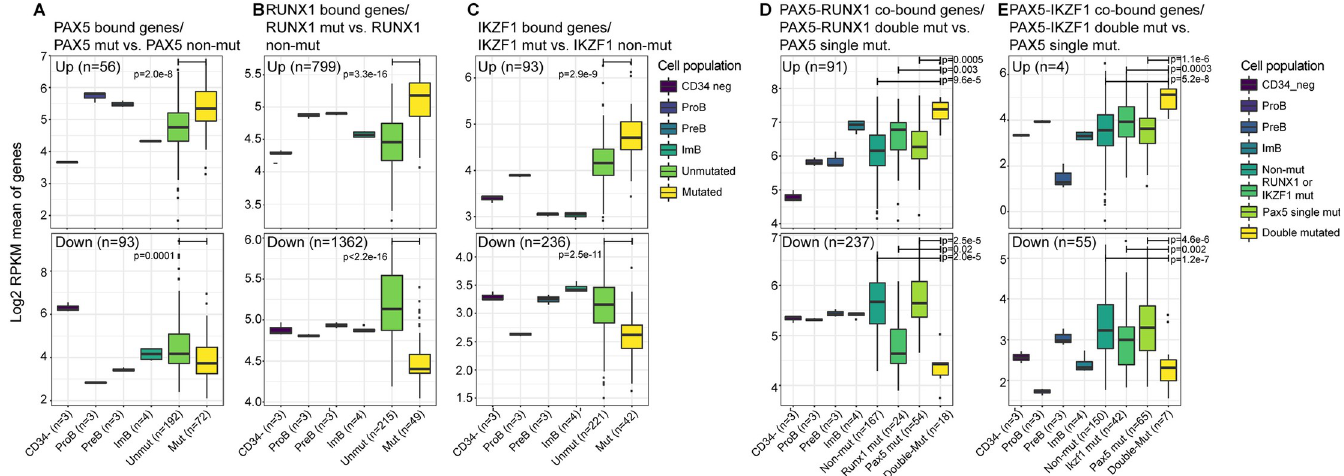
Fig 5. Mutations in B-lineage transcriptional regulators affects expression of their target genes in human leukemia. The figure displays diagrams over a differential expression analysis in a cohort of 264 B-ALL samples and 13 samples from normal HSC (CD34 - ) or B-cell progenitor (Pro-B, Pre-B or Immature B) populations as indicated. PAX5, RUNX1 and/or IKZF1 target genes are defined in the human B-ALL cell line NALM6 using ChIP- and PLAC-sequencing (for details see Methods). Boxplots describe the mean log2 RPKM gene expression for each sample category as defined by differential genes between mutated and unmutated samples (A-C) ; ( A) Expression of PAX5 bound genes in PAX5 mutated vs unmutated leukemia cells, (B) RUNX1 bound genes in RUNX1 mutated vs unmutated or ( C) IKZF1 bound genes in IKZF1 mutated vs unmutated B-ALL. Panel (D, E) displays boxplots of genes co-bound by ( D) PAX5-RUNX1 or ( E ) PAX5-IKZF1 differentially expressed in PAX5 only mutated vs. double mutated tumor cells. n = the number of differential genes between mutated and unmutated samples (A-C) or double-mutated and PAX5 single- mutated samples (D, E). Mann-Whitney U -test p-values are shown.